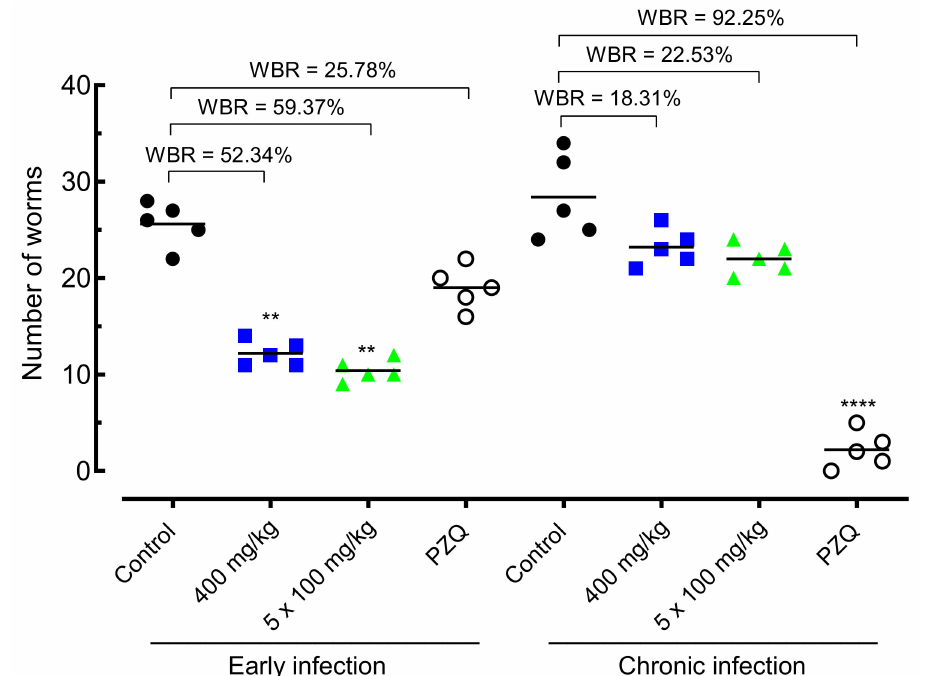
Figure 4. Effect of amiodarone on the parasite burden of mice harboring either early or chronic S. mansoni infection. Amiodarone (single dose of 400 mg/kg or 100 mg/kg for five consecutive days), praziquantel (PZQ, 400 mg/kg), and vehicle (control) were administered 21 days (early infection) or 49 days (chronic infection) post-infection by oral gavage. On day 63 post-infection, all animals were euthanized, and parasite burdens were determined. Points represent data from individual animals ( n = 5 per group). Horizontal bars represent median values. ** p < 0.01, **** p < 0.0001 compared with infected untreated control. WBR, worm burden